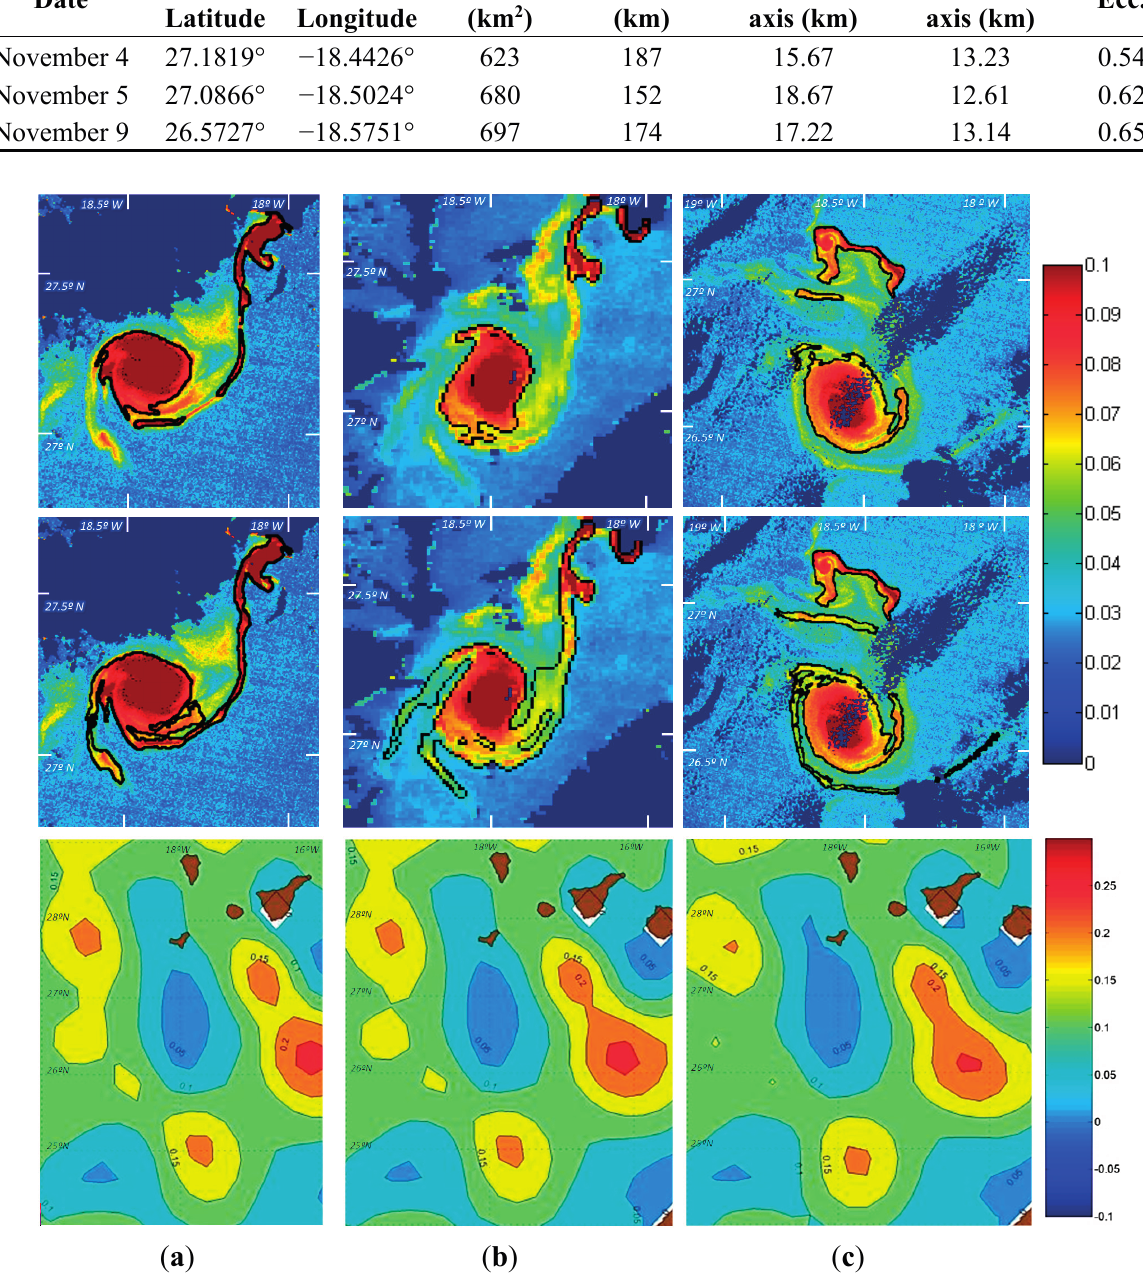
Figure 9. Add Contours of the eddy and its filaments, overlaid on the MERIS and MODIS K d images in m − 1 , after the initial segmentation (first row) and the structure growing (second row) modules; and Sea Surface Height Anomaly product in cm (last row): ( a ) 4 November 2011; ( b ) 5 November 2011 and ( c ) 9 November